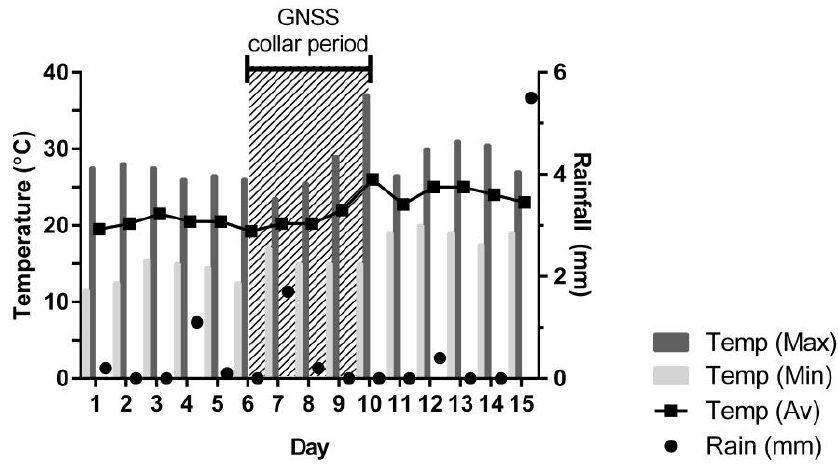
Figure 1. The daily recorded average ( ), minimum (light grey), and maximum (dark grey) temperature (°C) and rainfall ( ; mm) over the study. The shaded section highlights the GNSS collar period on days 6–10. The highest recorded temperature of 37.6 °C occurred on Day 10 of the study.